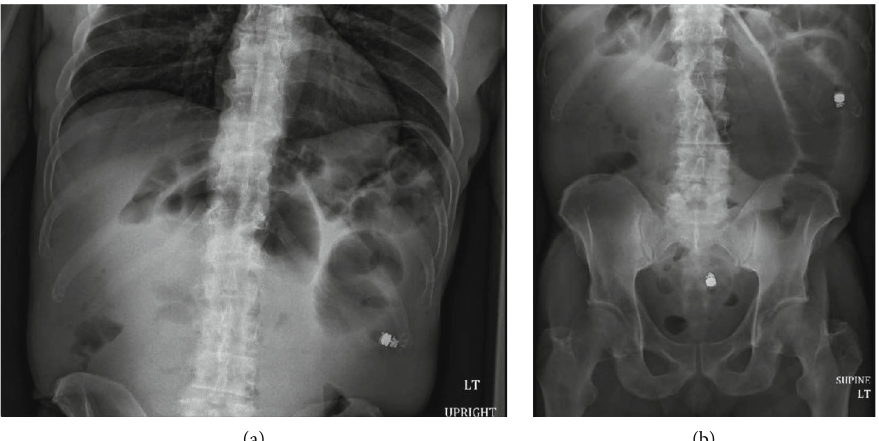
Figure 1: Upright (a) and supine (b) abdominal X-rays taken on admission showing dilated loops of small bowel in the central and left abdomen.